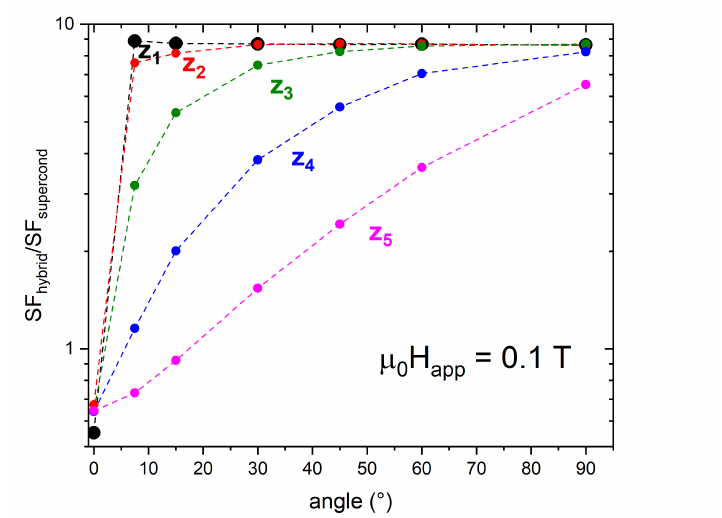
Figure 11. Dependence of the ratio between the SFs of the configuration HCC3 and those of the single SC cup, SF hybrid / SF supercond , on the tilt angle of the applied magnetic field having magnitude 0.1 T. The data refer to the positions z 1 (black dots), z 2 (red dots), z 3 (green dots), z 4 (blue dots), and z 5 (magenta